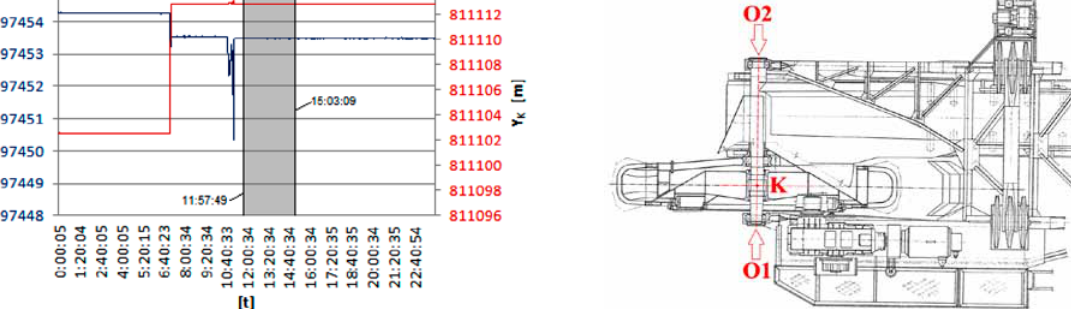
Fig. 6. Positions of GNSS and inertial sensors at the K800/103 excavator